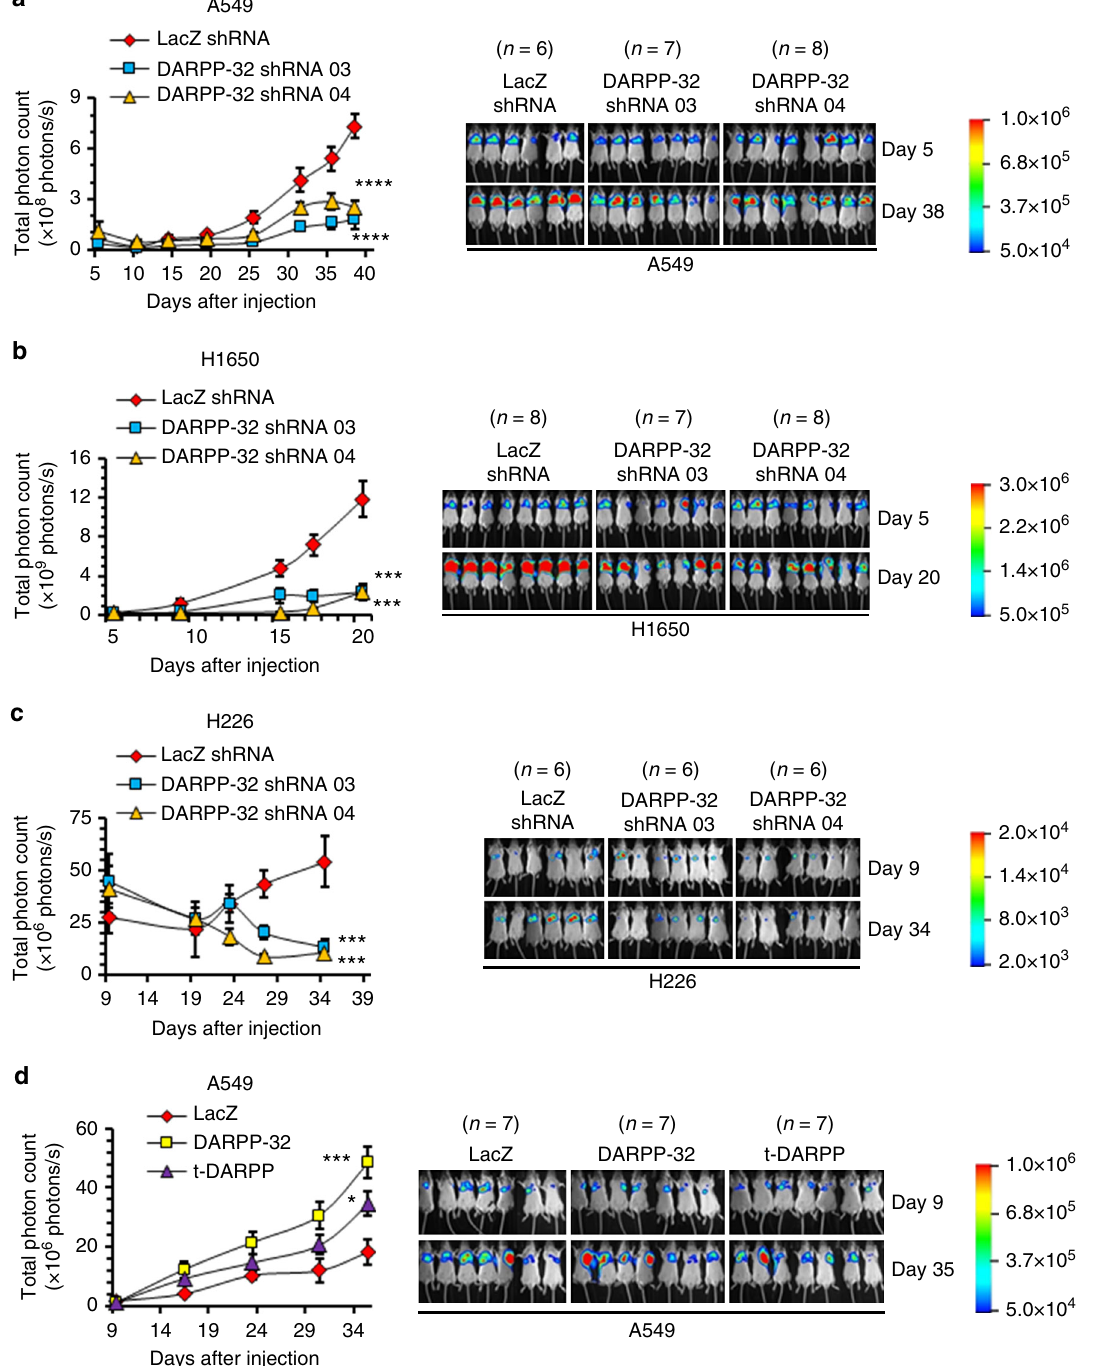
Fig. 6 DARPP-32 knockdown decreases tumor progression in a human lung tumor xenograft model. a Luciferase-labeled human A549, b H1650 and c H226 cells transduced with lentivirus encoding control or DARPP-32 shRNAs were injected into the left thorax of SCID mice and imaged for luminescence on indicative days. d Luciferase-labeled human A549 cells overexpressing control, DARPP-32 or t-DARPP clones were orthotopically injected into the left thorax of SCID mice and imaged for luminescence on indicative days. Representative in vivo images of SCID mice are depicted. Total luminescence intensity (photon count) was calculated using molecular imaging software. The colored bar represents the numerical value of luminescence. Error bars indicate SEM. * P < 0.05, *** P < 0.001 and **** P < 0.0001, one-way ANOVA followed by Dunnett ’ s test for multiple apoptosis 10 . The T75 phosphorylation residue shared by DARPP- major underlying mechanism in the ability of cancer cells to 32 and t-DARPP was attributed to promoting cell survival 10 , and acquire resistance to molecular targeted therapies 53 . El-Rifai and a follow-up report by the same group suggested increased acti- colleagues 19 demonstrated that DARPP-32 promotes cell survival vation of Akt and Bcl2 is mechanistically responsible for t- and ge fi tinib resistance in gastric cancer cells by stimulating DARPP-mediated cancer cell survival 18 . Evasion of apoptosis is a EGFR phosphorylation and activating phosphatidylinositol